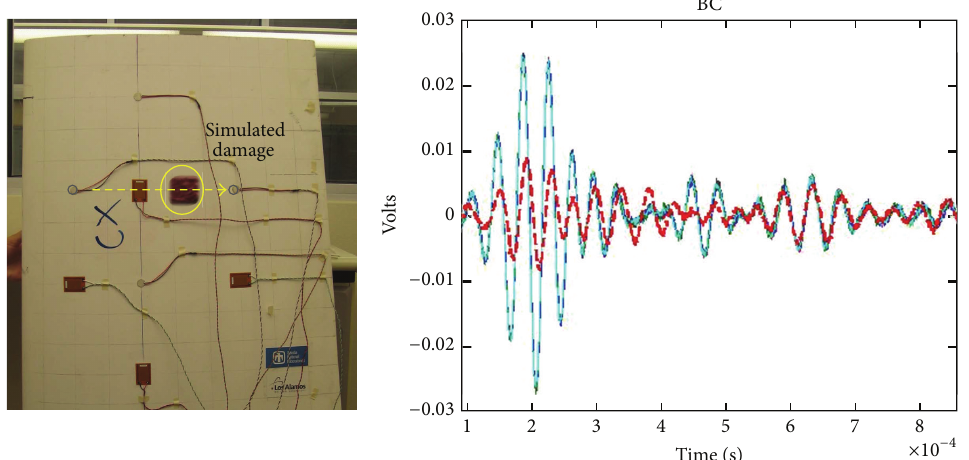
Figure 3: Turbine blade section with simulated damage and ten recorded baseline signals and damaged signal for path BC.